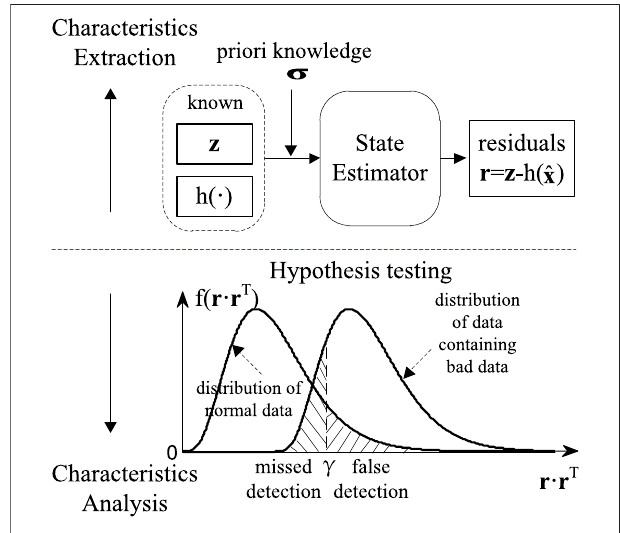
FIGURE 3 | Bad data detection based on state